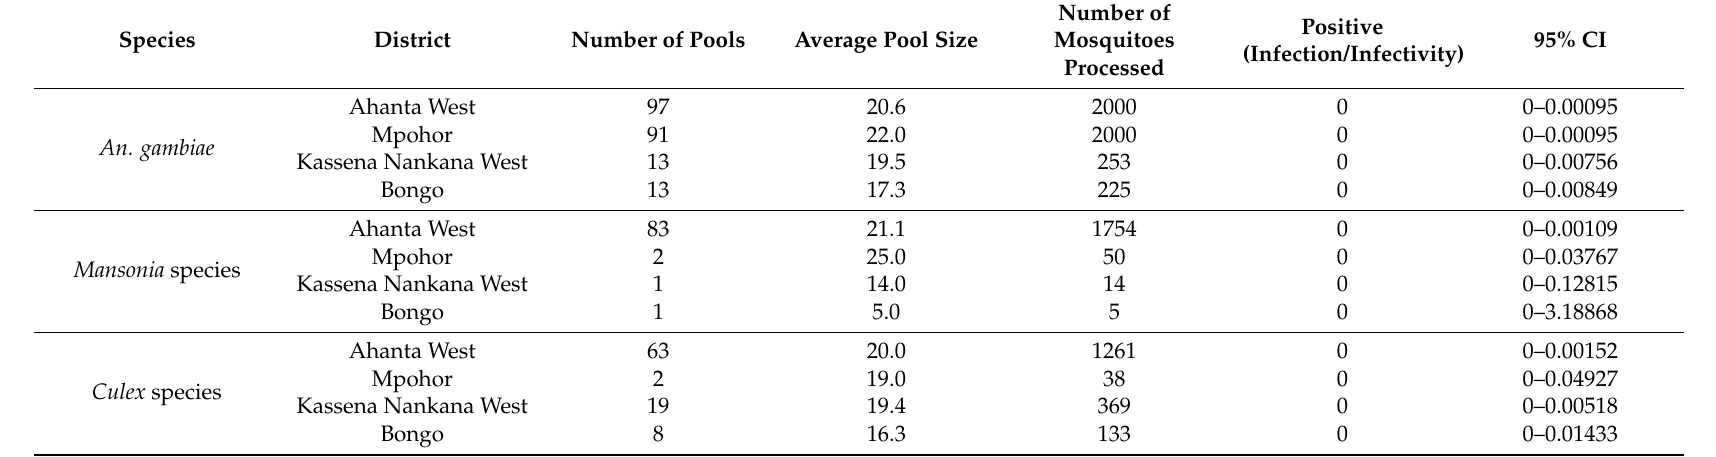
Table 5. Number of mosquito pools processed per study district from July 2015 to July